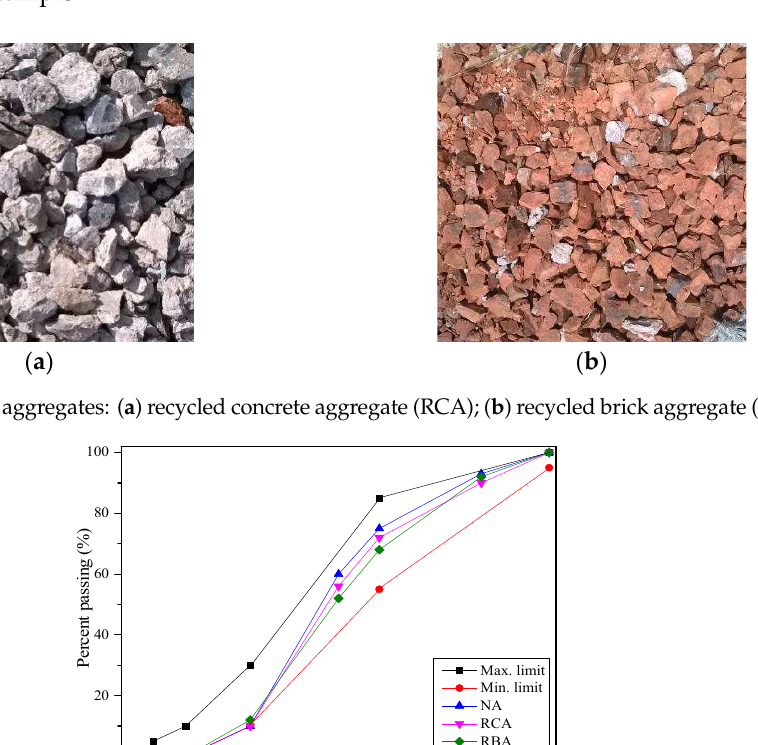
where w a is the 24-h water absorption of samples, m 0 is the weight of the soaked sample, and m 1 is the weight of the drying sample.